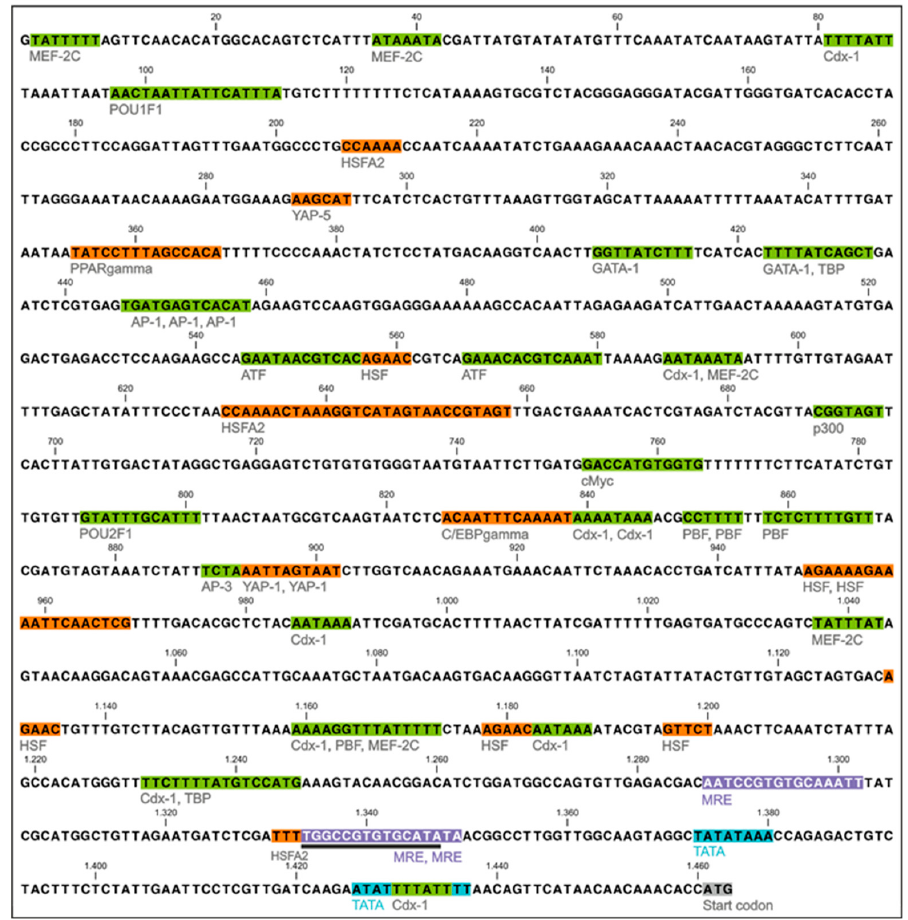
Figure 2. Nucleotide sequence of the promoter region (position 1 to 1460 bp upstream from the start codon), of the MT gene of Biomphalaria glabrata . Metal responsive elements (MREs) acting as potential binding sites for the presumed metal transcription factor I are highlighted in lilac. Potential transcription factor binding sites (TFBs) involved in stress response are marked in orange and hypothetical binding sites for regulatory transcription factors are marked in green. The putative TATA boxes are highlighted in blue and the start codon of the first exon is shaded in grey. Functional specification of TFBs identified using TRANSFAC: metal induction (lilac): MREs: aatccgtGTGCAaatt, tggccgtGTGCAtata, tggccgtGTGCAta (black line indicates palindromic MRE sequence of the MRE in opposite direction). Stress response (orange): HSF: GTTCT, AGAAC, agaaaattcaACTCG, AGAAAagaaaattca, TGAAGagaatatgcg; C/EBP γ : acaATTTCaaaat; PPAR γ : tatCCTTTagccaca; YAP: